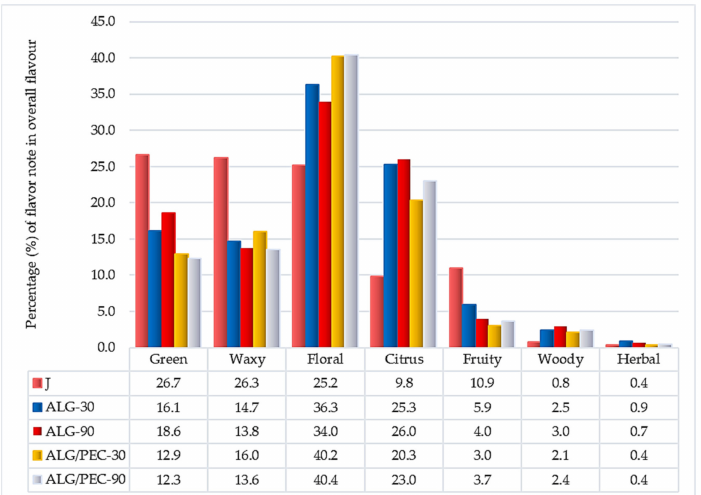
Figure 1. Percentage of flavor notes in the overall flavor of chokeberry juice and hydrogel beads (J: chokeberry juice, ALG, ALG/PEC: alginate, alginate/pectin as wall material(s), 30 and 90: different duration (minutes) of complexation. Alginate to pectin ratio was